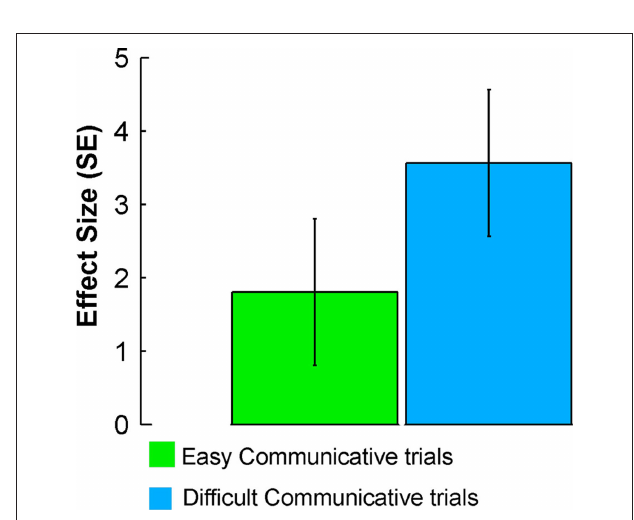
FIGURE 5 | Activity evoked in the receiver during EASY and DIFFICULT COMMUNICATIVE trials in the right pSTS (MNI coordinates: 56, − 38, 6). The plots show effect sizes (in standard error units) of cerebral activity evoked in the receiver during the observation epochs of EASY and DIFFICULT COMMUNICATIVE trials. The effect sizes were larger for DIFFICULT than EASY COMMUNICATIVE trials.